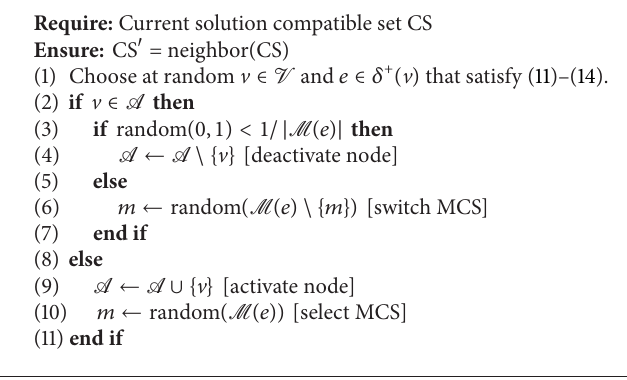
Algorithm 4: SA compatible set perturbation